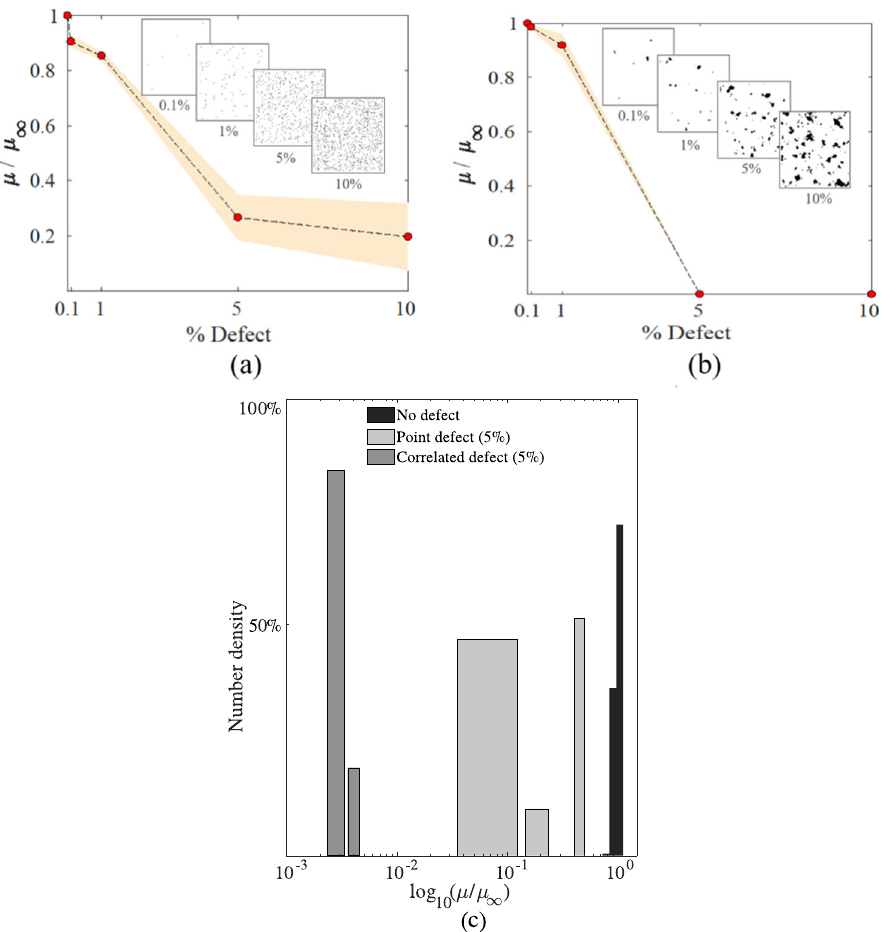
Fig. 4 Carrier mobility as a function of density of ( a ) point defects and ( b ) structural defects in a model morphology. The mobility was non-dimensionalized with respect to the mobility of perfect morphology with no defects. In ( b ), an average domain size of ~5% of total